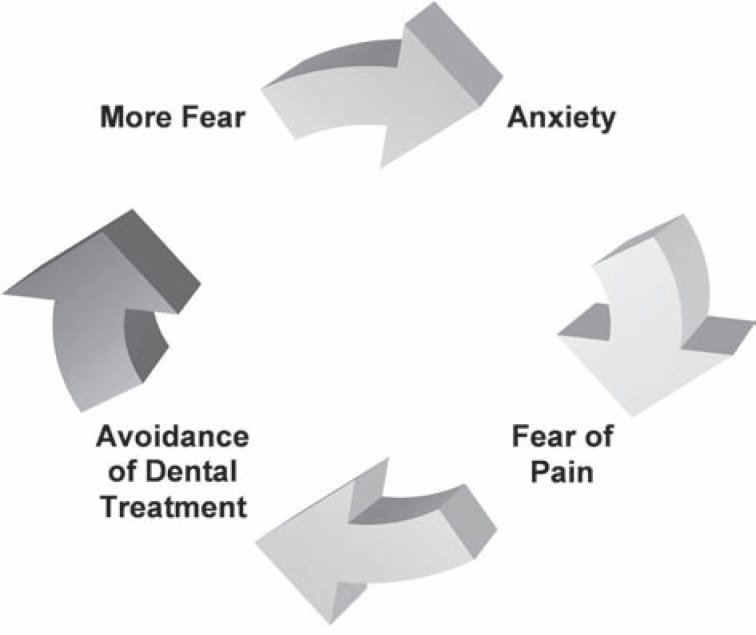
Vicious cycle of anxiety: modified from van Wijk and Hoogstraten25 (2009)